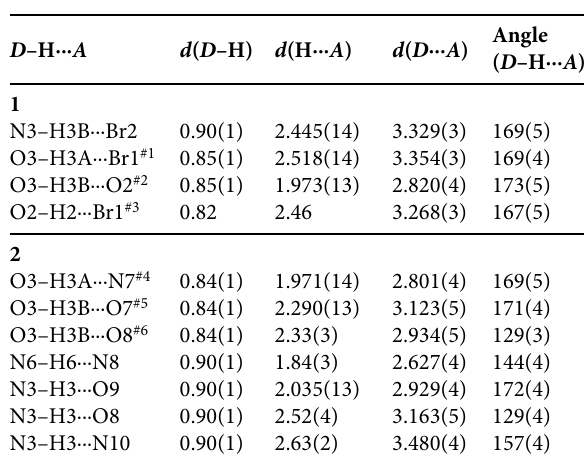
Table 3. Hydrogen bond distances (Å) and bond angles (°) for the